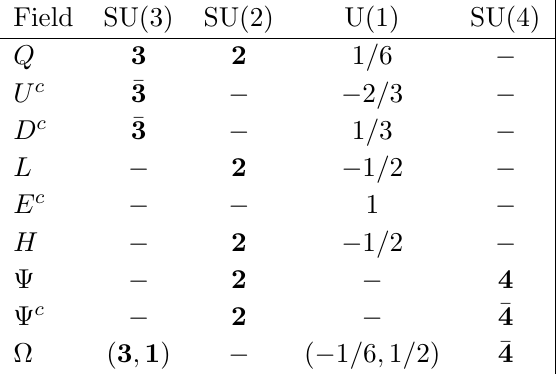
Table 15 . Fields and representations. There are three generations of each of the SM fermion (cid:12)elds but only one copy of the heavy fermion (cid:9) + (cid:22)(cid:9). H is the SM Higgs doublet and (cid:10) is a \bi-doublet" scalar (cid:12)eld which is in the fundamental representation of SU(3) (cid:2) U(1) (thought of as a subgroup of a larger SU(4)) and the anti-fundamental of SU(4). A TeV scale vev for (cid:10) is responsible